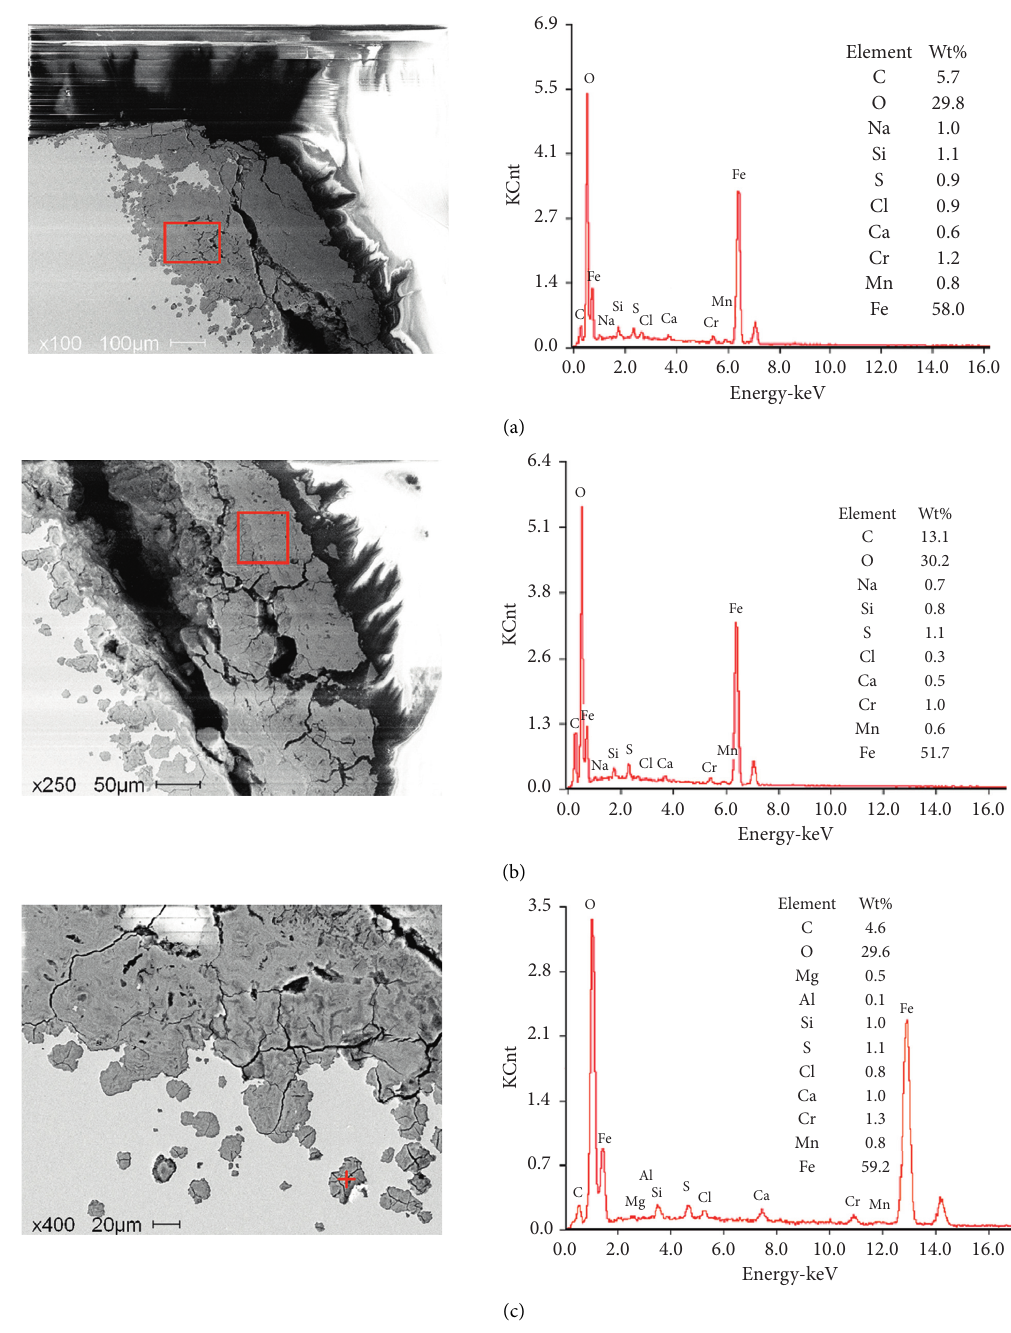
Figure 11: EDS energy spectrum analysis of corrosion products in pits of metallographic samples of transverse section. (a) Composition of corrosion products near the matrix in the pit corrosion area. (b) Composition of near-surface corrosion products in the pit corrosion area. (c) Composition of point corrosion products in the